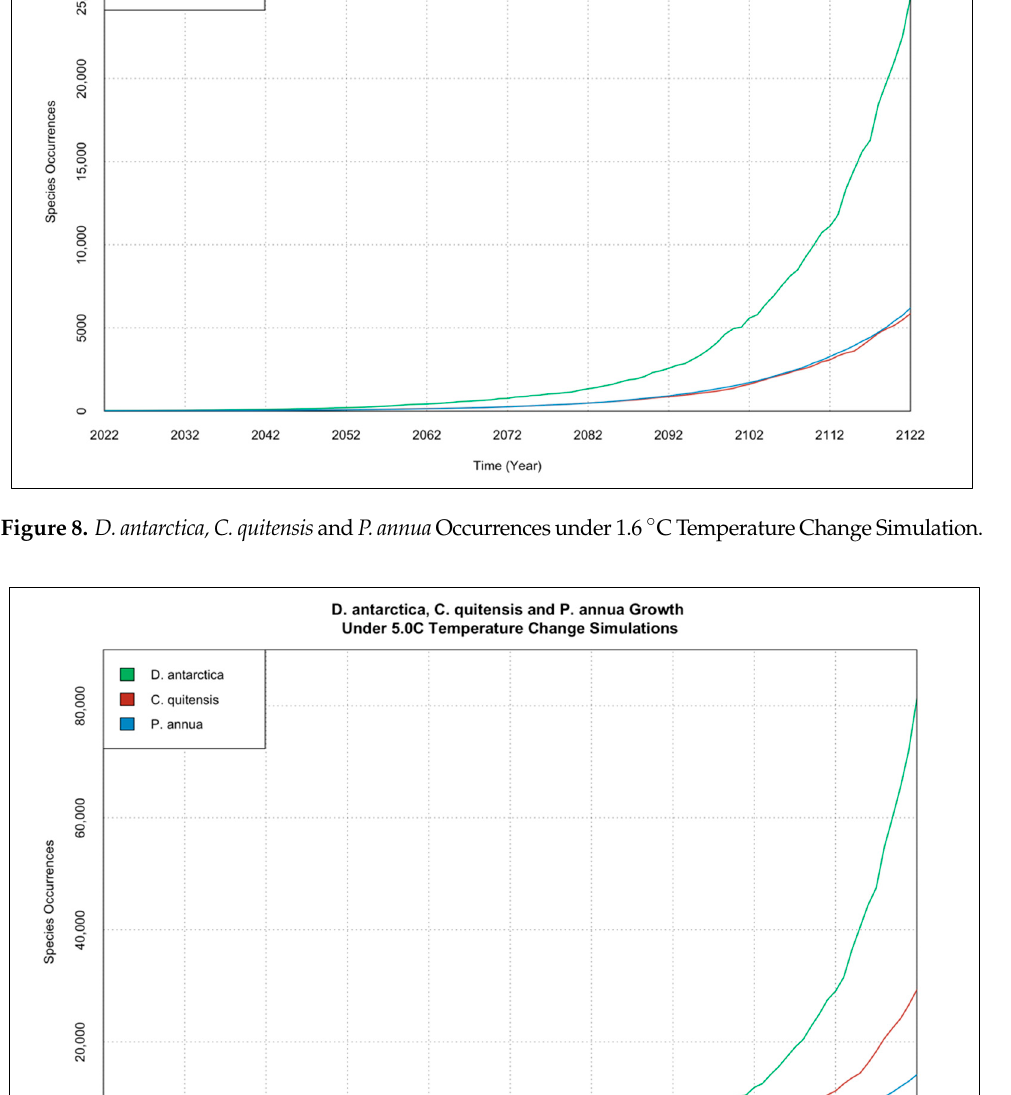
Figure 9. D. antarctica , C. quitensis and P. annua Occurrences under 5.0 °C Temperature Change Simulation.